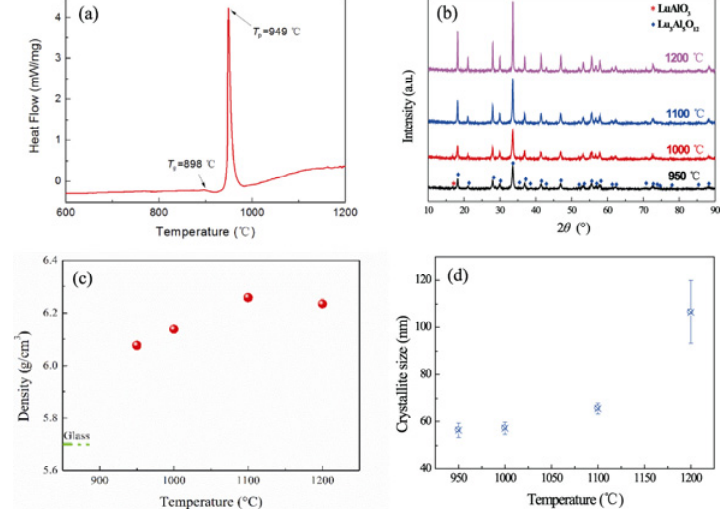
Fig. 1 (a) Differential scanning calorimetry curve of ALu28 glass-based precursors synthesized through containerless solidification process; (b) XRPD patterns, (c) densitiy, and (d) crystallite sizes of transparent materials (1.0 mm in thickness) crystalized from ALu28 glass-based precursors at 950, 1000, 1100, and 1200 ℃ for 2